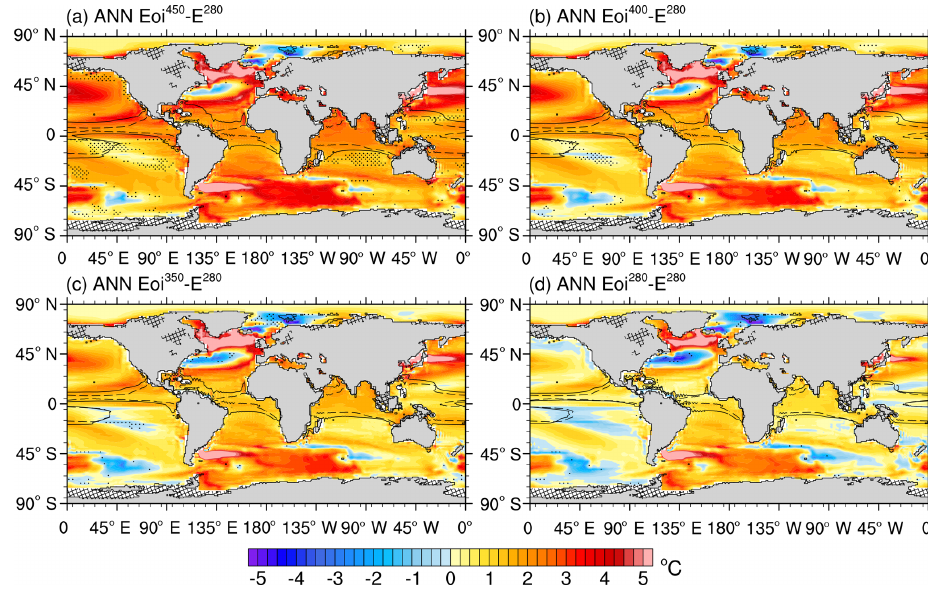
Figure 9. Pliocene MASST anomalies against E 280 . (a) Eoi 450 –E 280 , (b) Eoi 400 –E 280 , (c) Eoi 350 –E 280 and (d) Eoi 280 –E 280 . Dotted contour lines indicate E 280 28 ◦ C warm pool, whilst the solid contour indicates the Pliocene 28 ◦ C warm pool. Cross hatching indicates regions in which either modern or Pliocene experiments have contrasting land surface. Stippling indicates regions in which there is no statistical difference at a 95% confidence criterion. Table 7. Characteristics of the Atlantic and Pacific meridional overturning circulations (AMOC and PMOC). ID AMOC max